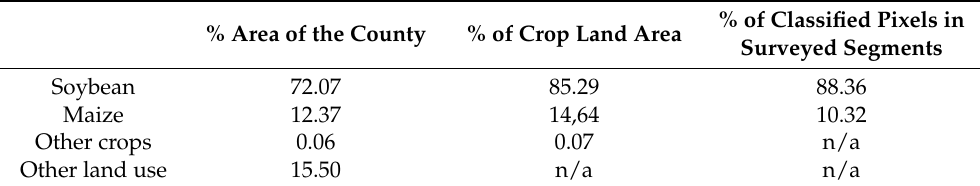
Table 2. Percentage of each class derived from the image classification.